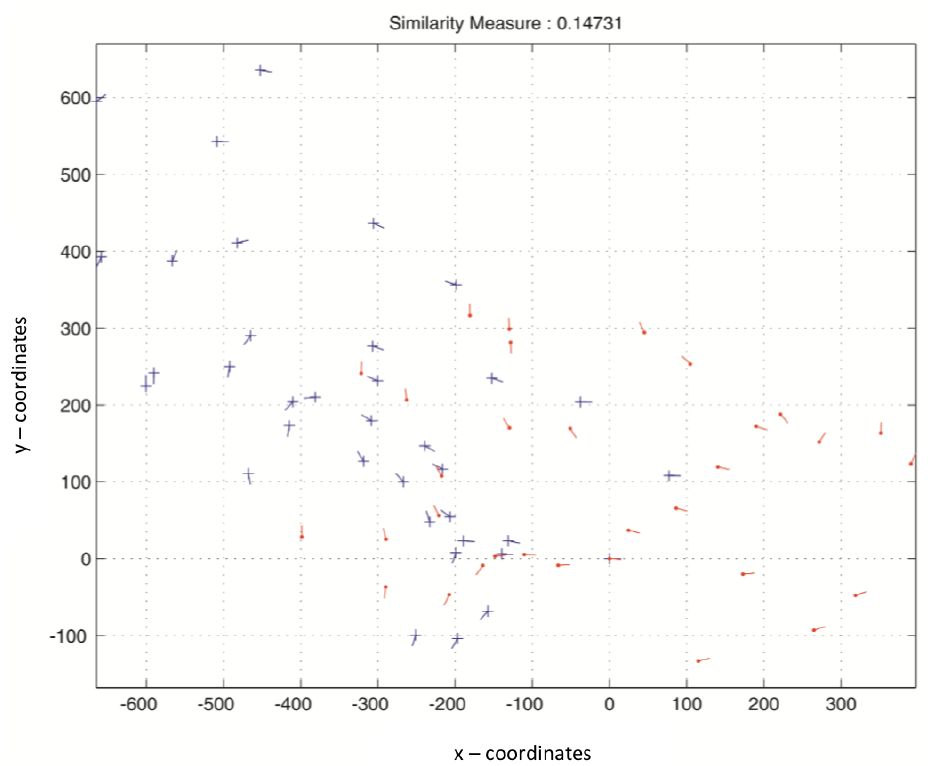
Figure 10. Matching score between two transformed fingerprint templates of two different users in the same